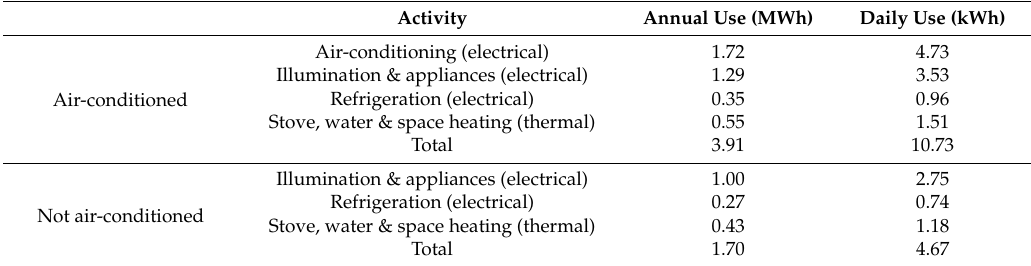
Table 3. Energy use of different activities in air-conditioned and not air-conditioned dwellings in Mexico.